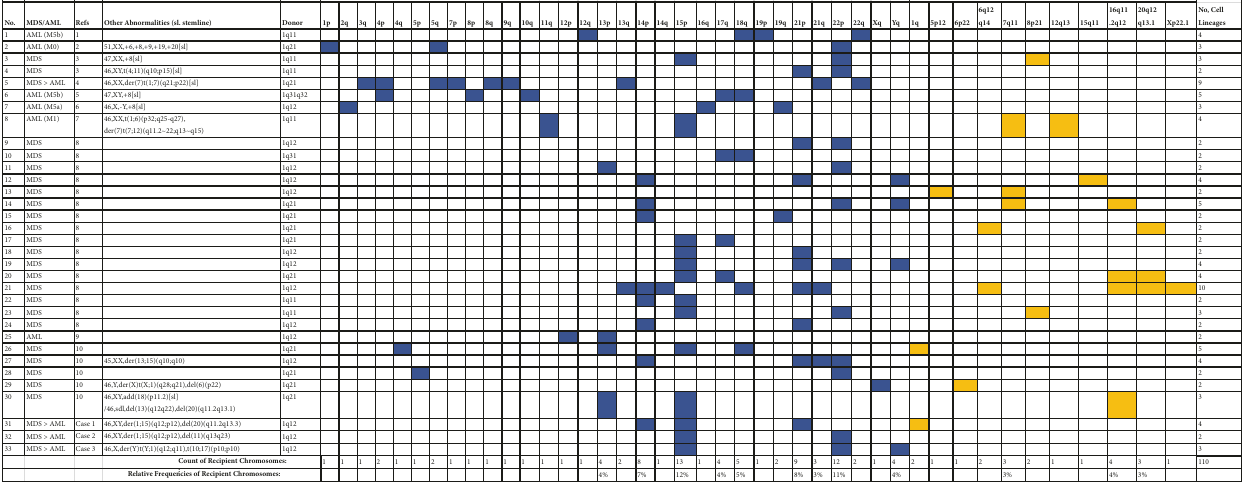
might be related to the loss of telomeric function [4]. Copy number gain of 1q involving pericentromeric breakpoints had been seen frequently in hepatocellular carcinoma. It was postulated that hypomethylation of satellite 2 DNA at 1q12 alters the interaction between the CpG-rich satellite